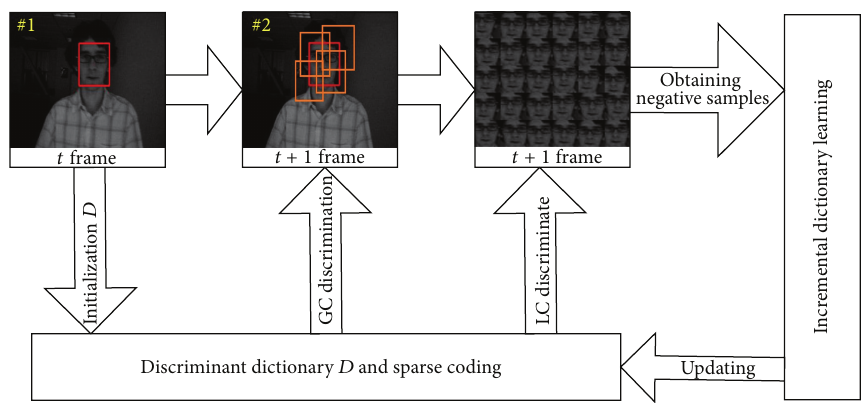
Figure 1: Diagram of targets tracking via sparse representation global and local